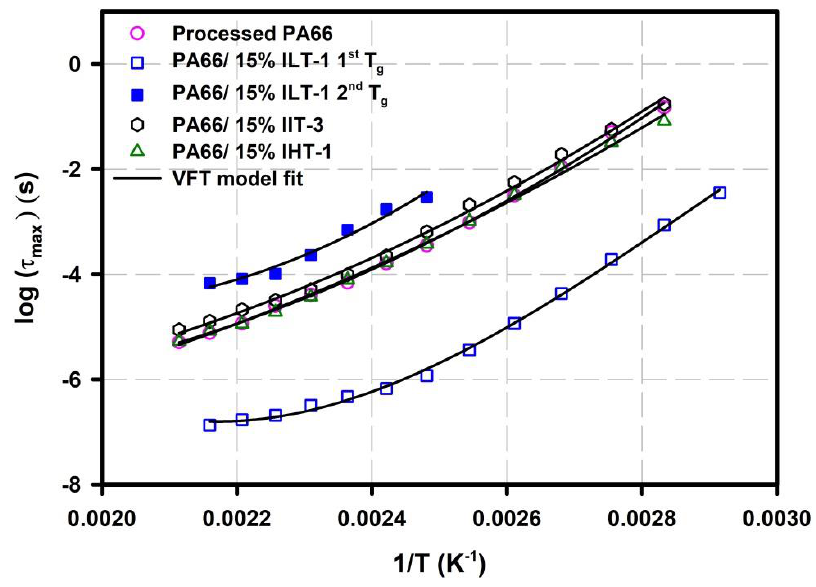
Figure 9. The characteristic relaxation times of the studied PA66 / P-glass systems and processed virgin PA66 as a function of temperature. Solid lines represent the VFTH equation fits.